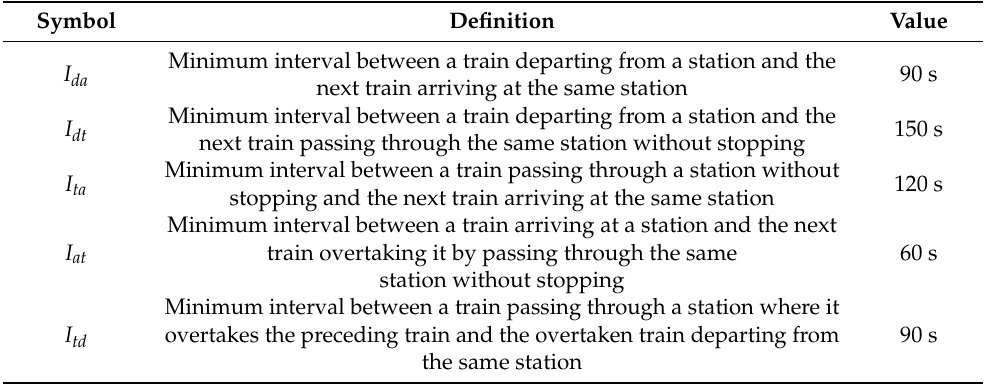
Table 4. t min values.